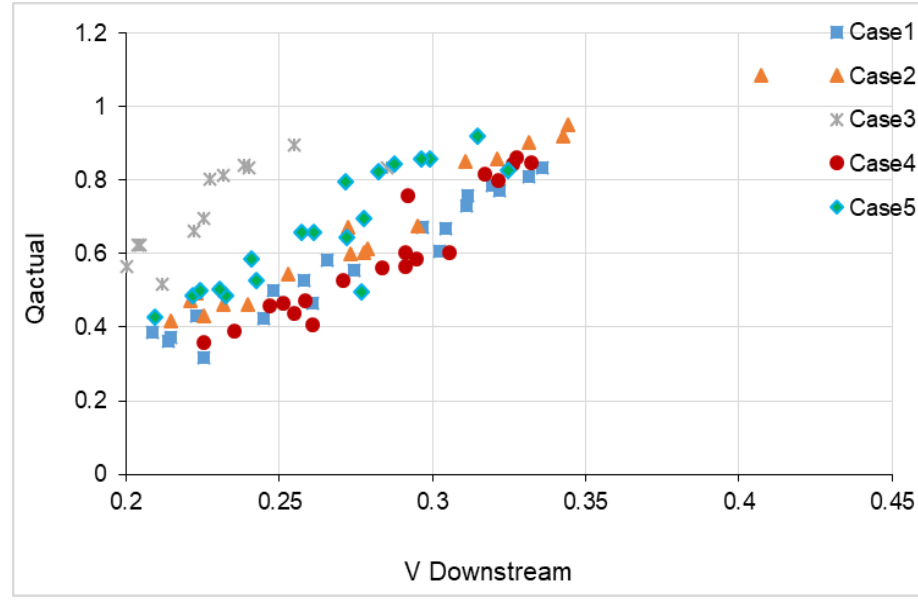
Figure 9. Relation between actual discharge and downstream flow velocity